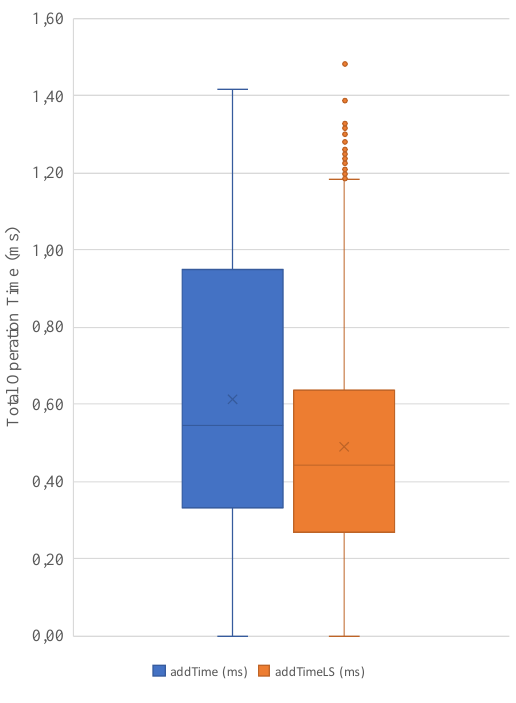
Figure 6. Boxplot for the addTime operation (without and with the Load-shedding enabled) throughout 5 minutes considering the measures under 2 ms for better visibility (Simulations 1 and